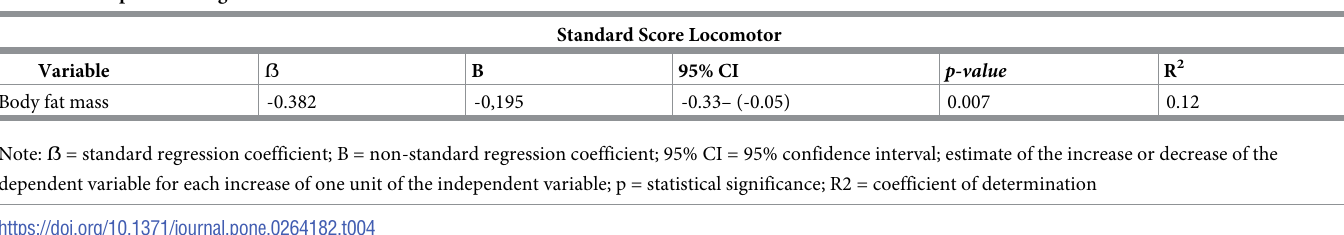
Table 4. Multiple linear